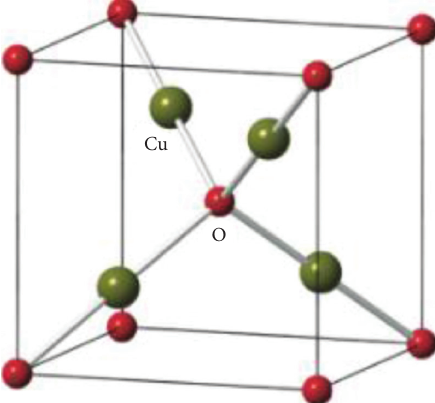
Figure 2: The graph of Cu